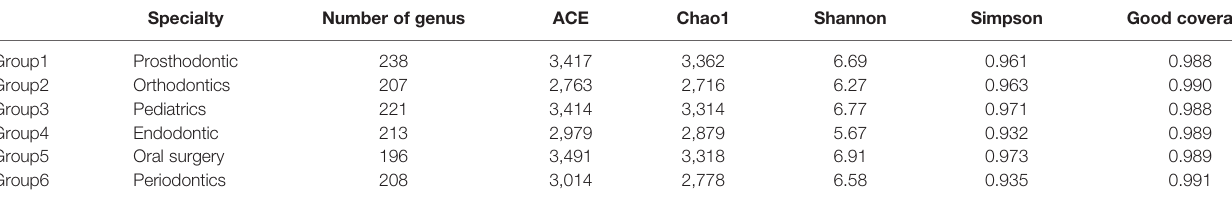
TABLE 4 | Number of genus, alpha-diversity index and Good_coverage for bacteria of six